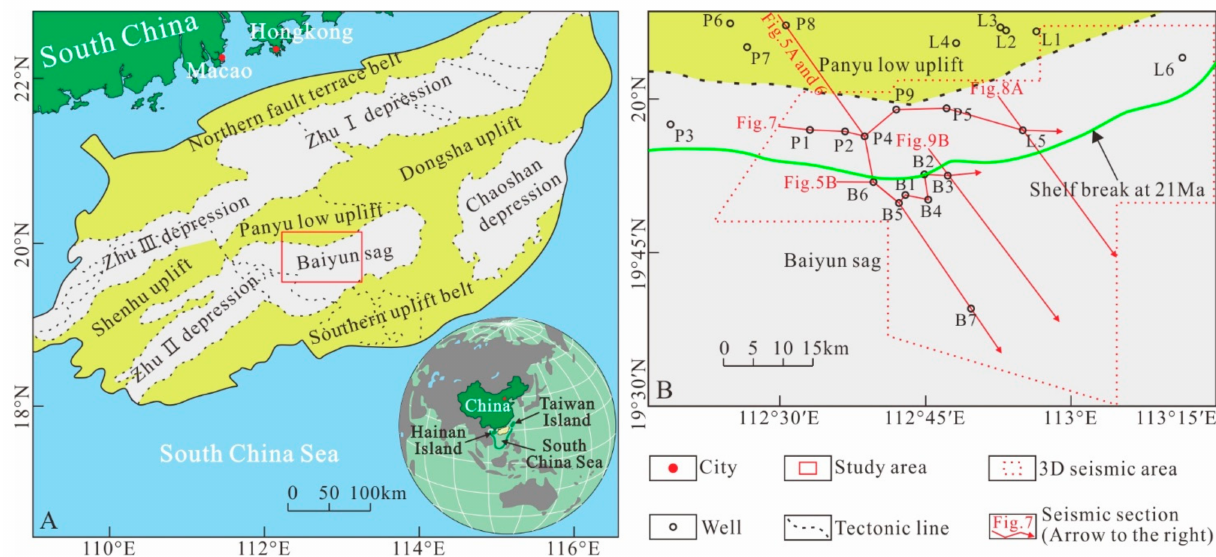
Figure 1. ( A ) Location map showing the tectonic compartmentalisation of the Pearl River Mouth Basin in the Northern South China Sea. ( B ) Location distribution of research data. The study area located in the Panyu low uplift and Baiyun sag. Note the forced regressive deposits mainly developed in the northern Baiyun